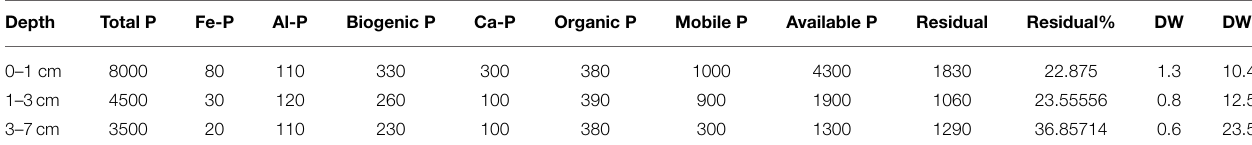
TABLE 2 | Concentration (mg/kgDW) of the diverse form of Phosphorus.